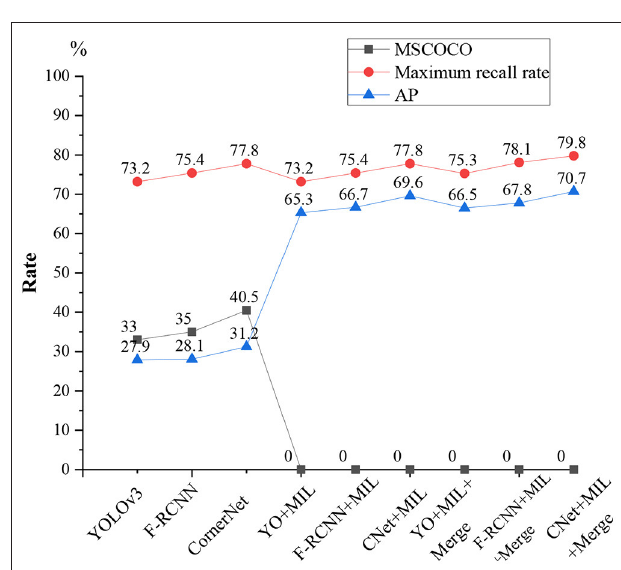
FIGURE 14 | Volleyball video detection